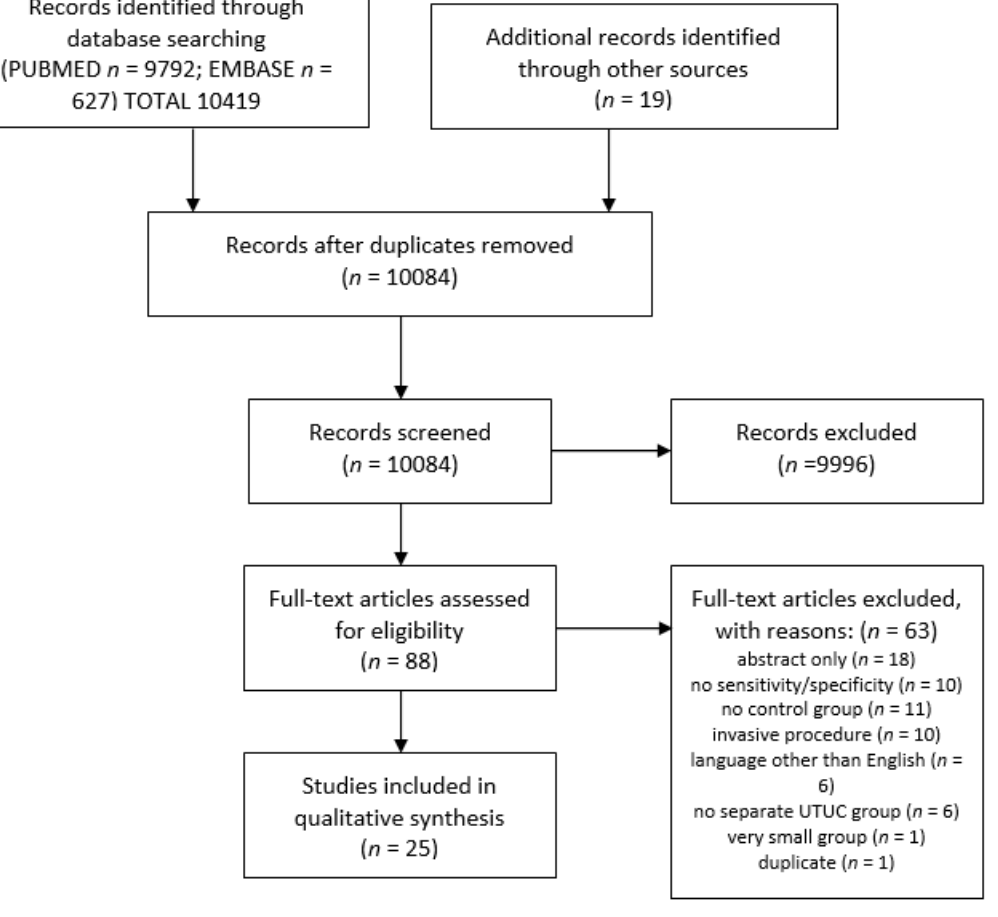
Figure 1. PRISMA flow diagram.